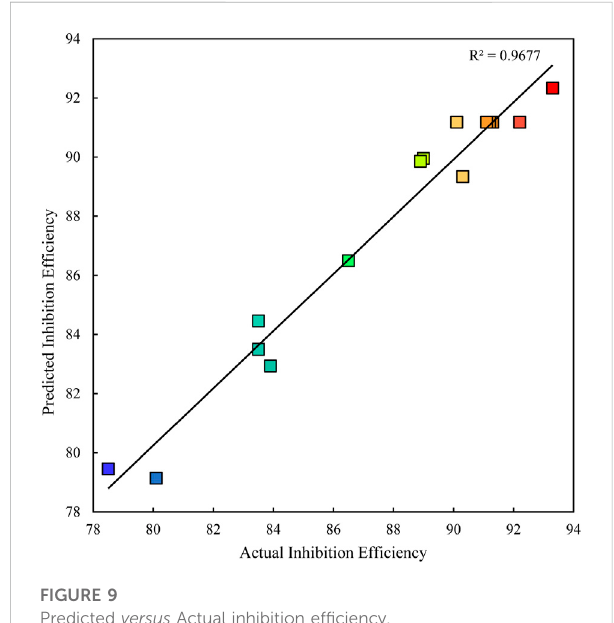
FIGURE 9 Predicted versus Actual inhibition ef fi ciency.